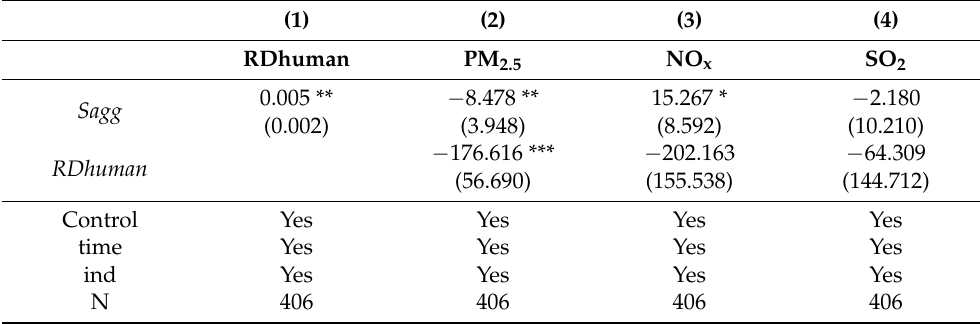
Table 16. Test of the mediating role of human capital in the agglomeration of the producer.